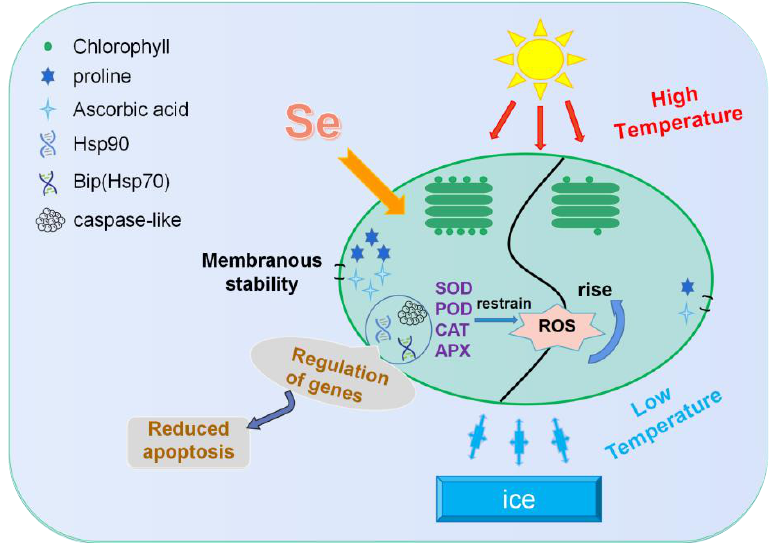
Figure 2. Patterns of Se mitigating temperature stress in plants. The ellipse indicates plant leaf cells under high and low-temperature stress, the left half indicates cells treated with Se.